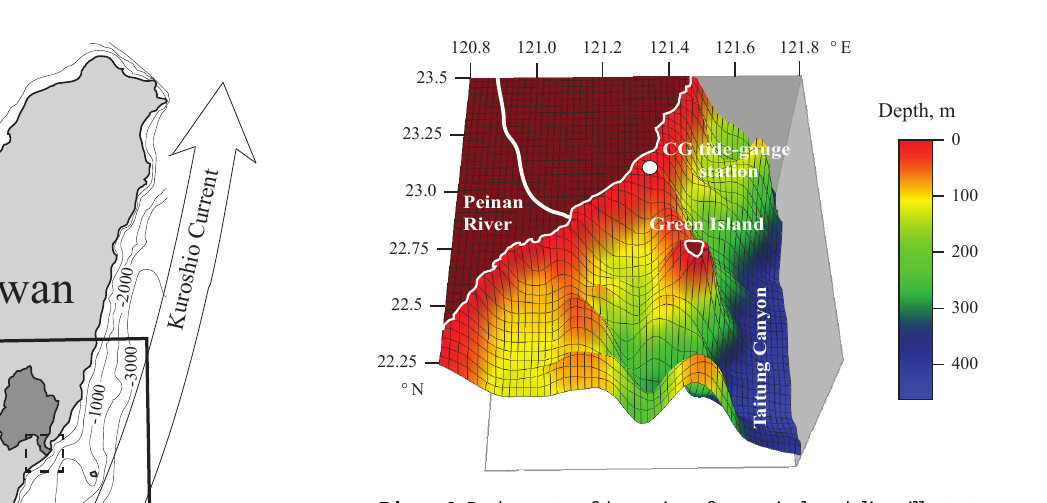
Figure 2. Bathymetry of the region of numerical modeling, illustrat- ing deposition of the Green Island, Taitung Canyon, two submarine canyons east of the Green Island, as well as locations of the Peinan River and the CG tide-gauge